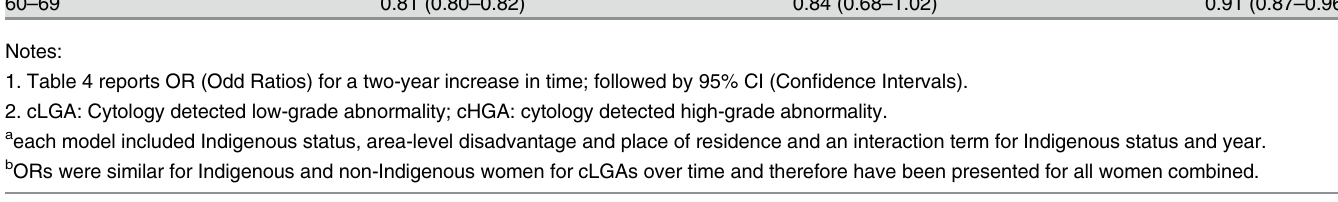
each model included Indigenous status, area-level disadvantage and place of residence and an interaction term for Indigenous status and year. b ORs were similar for Indigenous and non-Indigenous women for cLGAs over time and therefore have been presented for all women